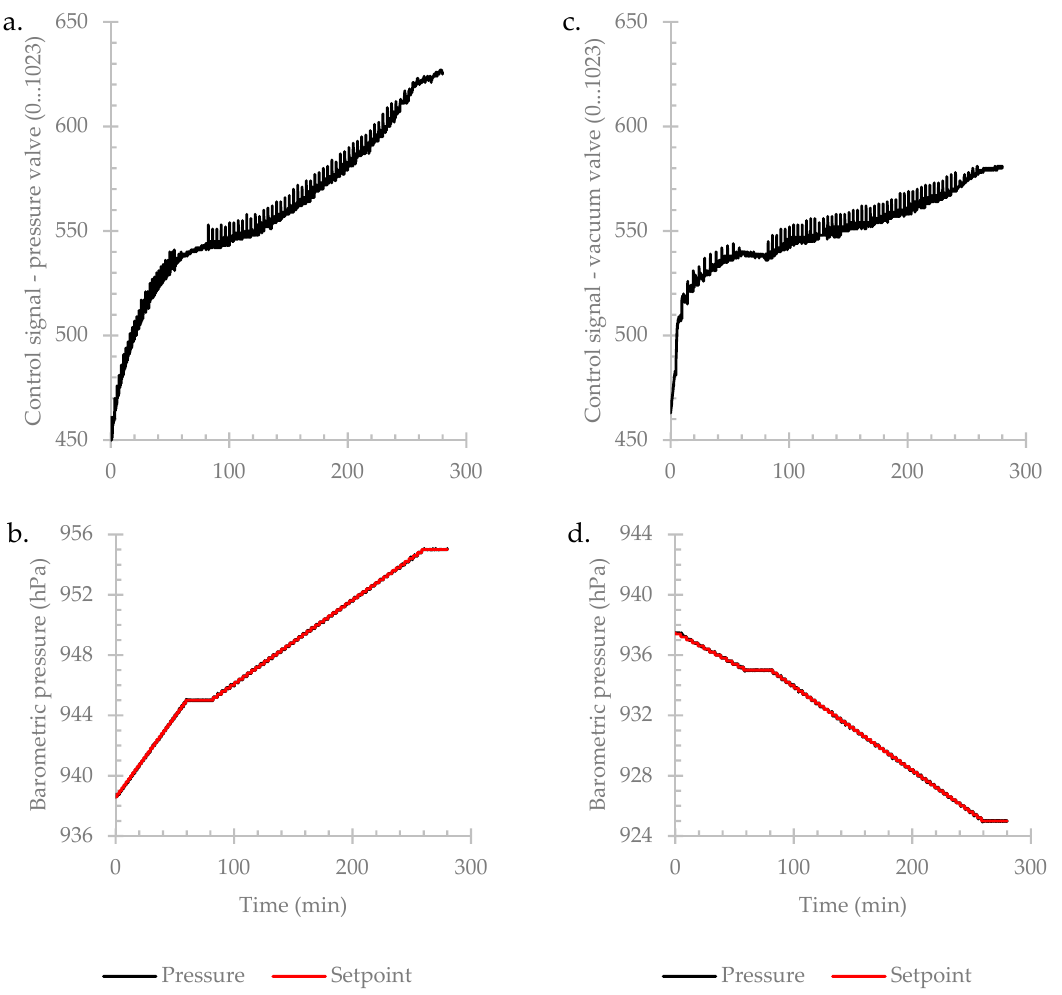
Figure 10. Results of long-term tests run to demonstrate that the chamber works as expected: ( a ) test 3—control signal fluctuations while controlling the pressure valve; ( b ) test 3—rising pressure within the barometric chamber; ( c ) test 4—control signal fluctuations while controlling the vacuum valve; ( d ) test 4—decreasing pressure within the barometric chamber.